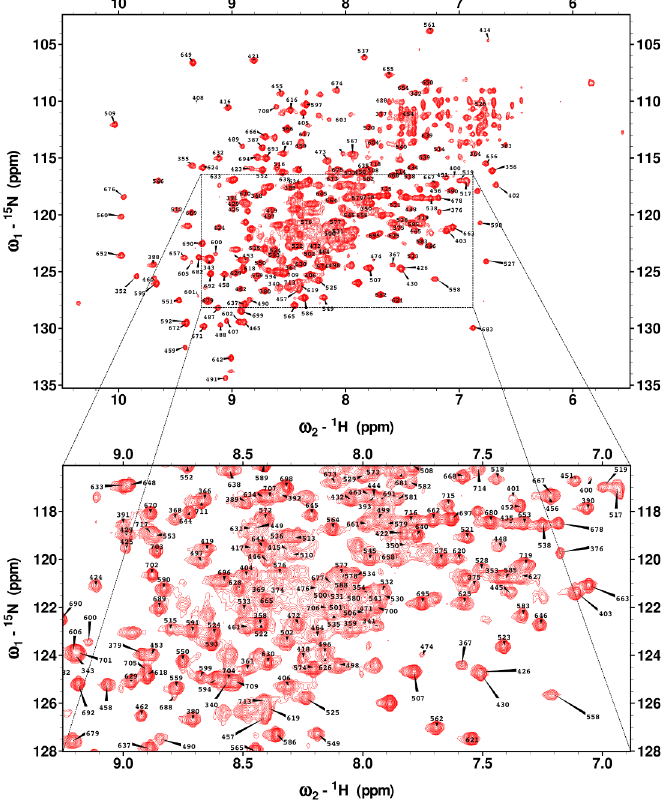
Fig 1. 1 H- 15 N TROSY spectrum of MALT1 Casp-Ig3 (338 – 719) with the assigned amino acid residue number annotated.